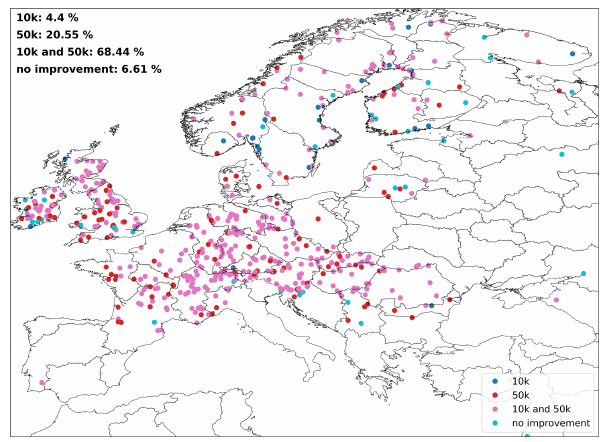
Figure B1. Map of stations where the 1K run showed improvement with respect to only the 10K run, only the 50K run, both runs, or none of the runs.